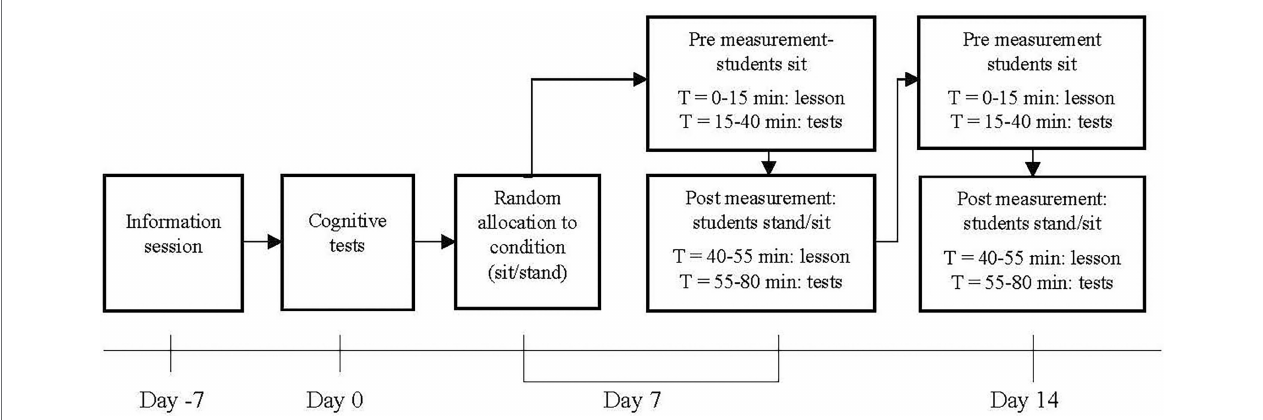
FIGURE 1 | Schematic representation of the study design. Students who sat in the first test session at day 7, stood in the second test session at day 14 and vice versa.